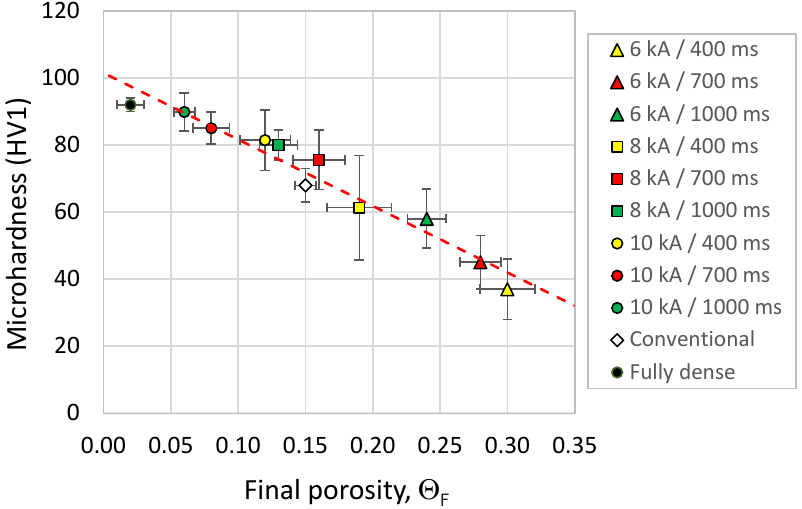
Figure 8. Mean microhardness (HV1) vs. final porosity ( Θ F ) for the different MF-ERS compacts, the conventionally sintered compact and the fully dense sample.